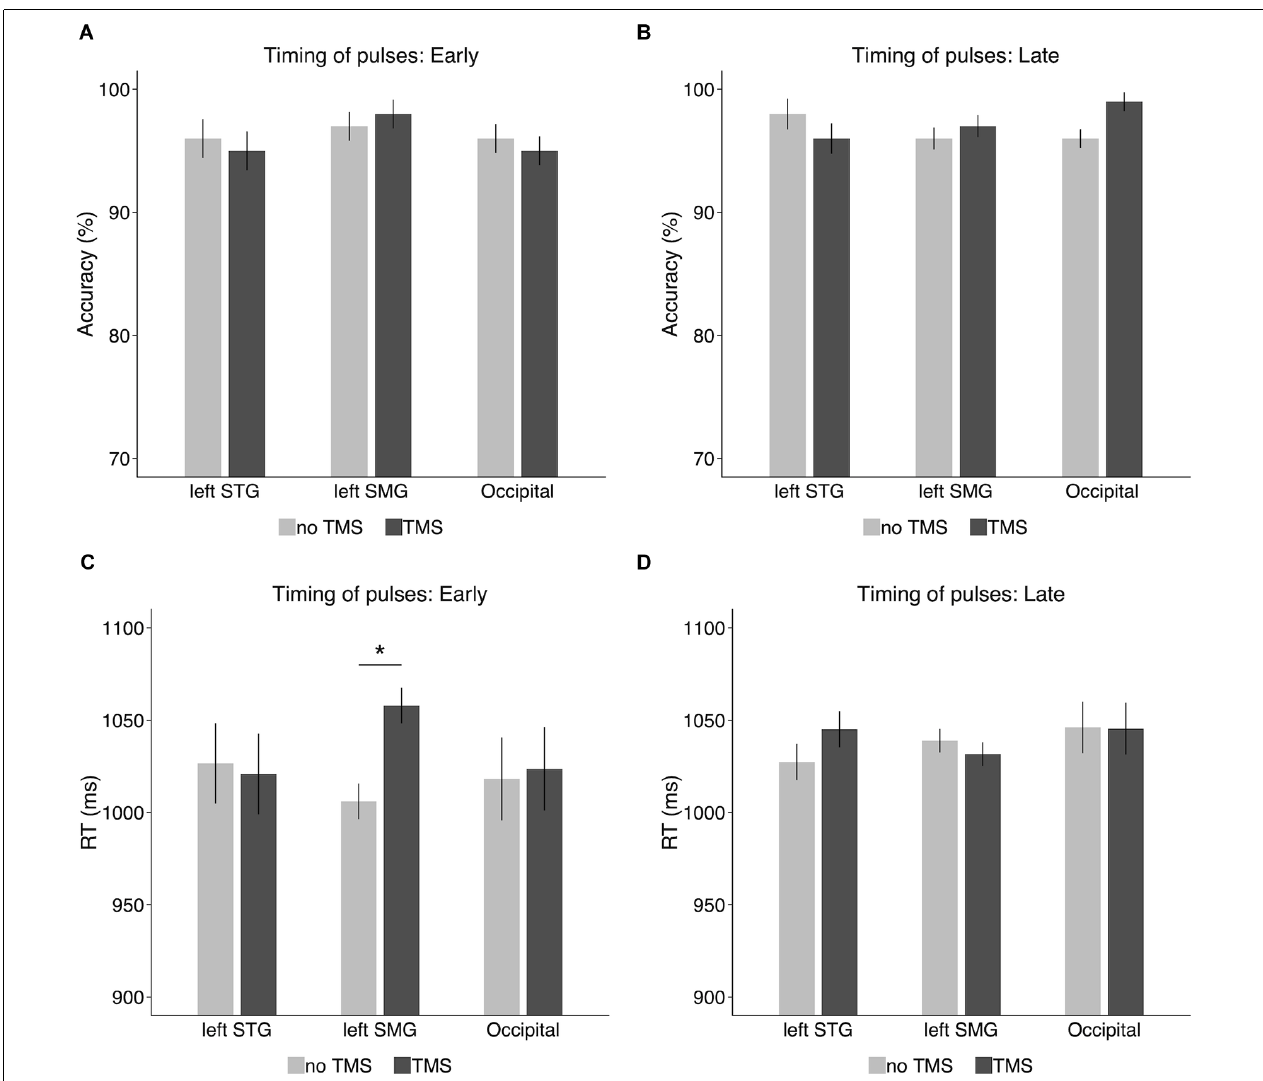
FIGURE 5 | Accuracy and response times in the TMS experiment for (A,C) the early timing condition (i.e., the onset of the delay period) and (B,D) the late timing condition (i.e., 600 ms after the onset of the delay period). Error bars represent 95% within-subjects confidence intervals around the mean. * p < 0.05.